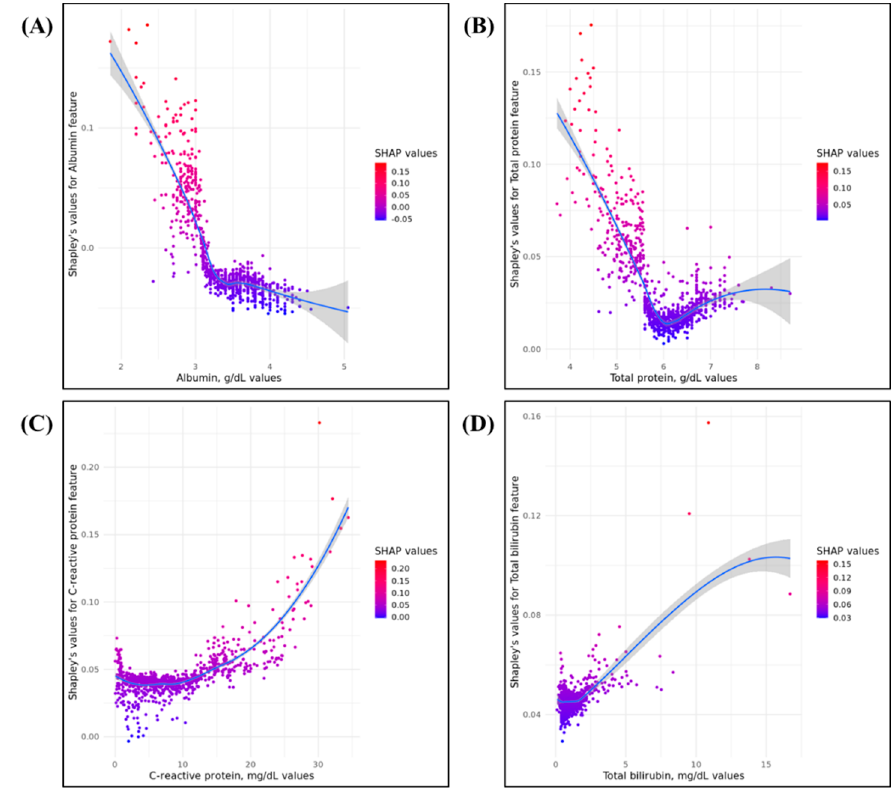
Figure 2. SHAP feature dependence plots for four variables: ( A , B ) higher values of albumin and total protein are associated with higher risk of 30-day postoperative mortality; ( C , D ) higher C-reactive protein and total bilirubin are associated with lower risk of 30-day postoperative mortality.